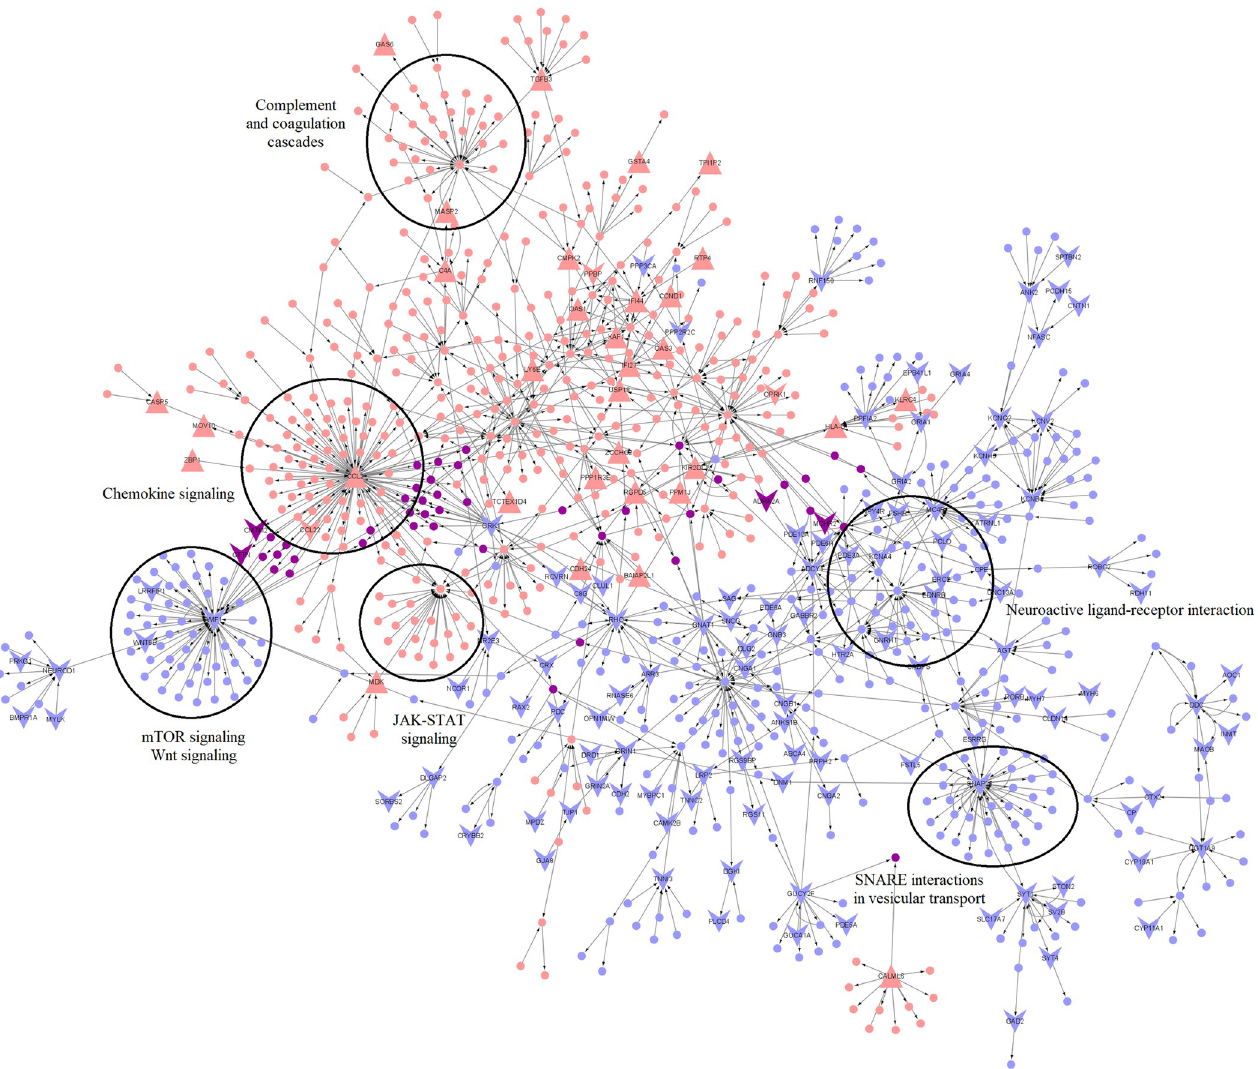
Fig 5. TopNet for CHD vs Healthy. The red nodes represent genes in the top active network, the blue nodes represent nodes of the top repressed network, and the purple nodes indicate nodes common to both. The DEGs are labeled and represented with larger node sizes. The upper-facing triangles represent genes that are upregulated, and lower-facing triangles indicate nodes that are downregulated in each of the test conditions compared to the reference groups. Enrichment of some of the hub genes has also been shown.